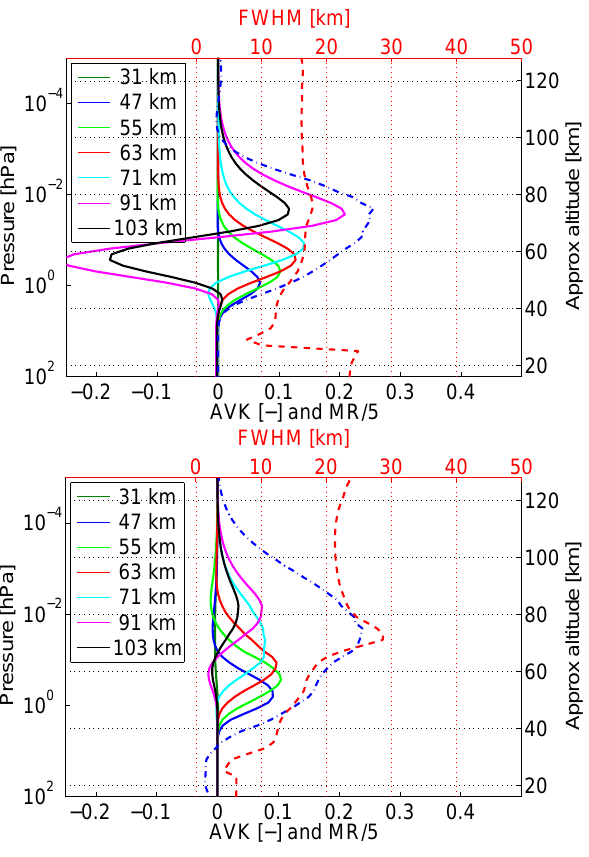
Fig. 5. Solid lines show the averaging kernels from 26 June 2006 in vmr (a) and fractional (b) units for different altitudes. The blue dash-dotted line is the measurement response divided by 5. The red dashed line shows the FWHM of the averaging